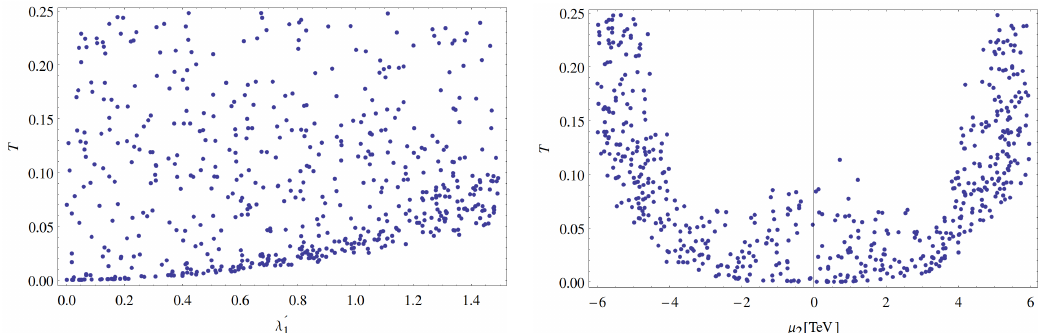
Figure 13. Value of the T -parameter for the points of the scan. On the left dependence with λ 0 on the right dependence with µ 2